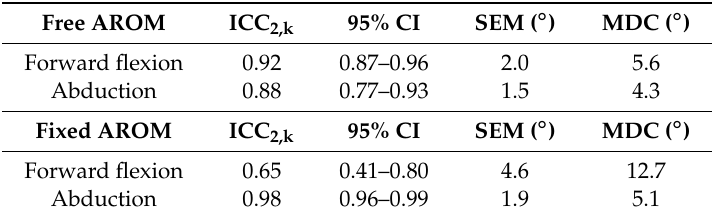
Table 4. HumanTrak Inter-rater reliability ( n = 15).